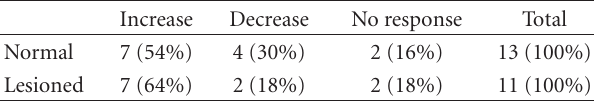
Table 3: Response of GP neurons to 1 nmol oxotremorine in normal and ipsilateral striatum-lesioned